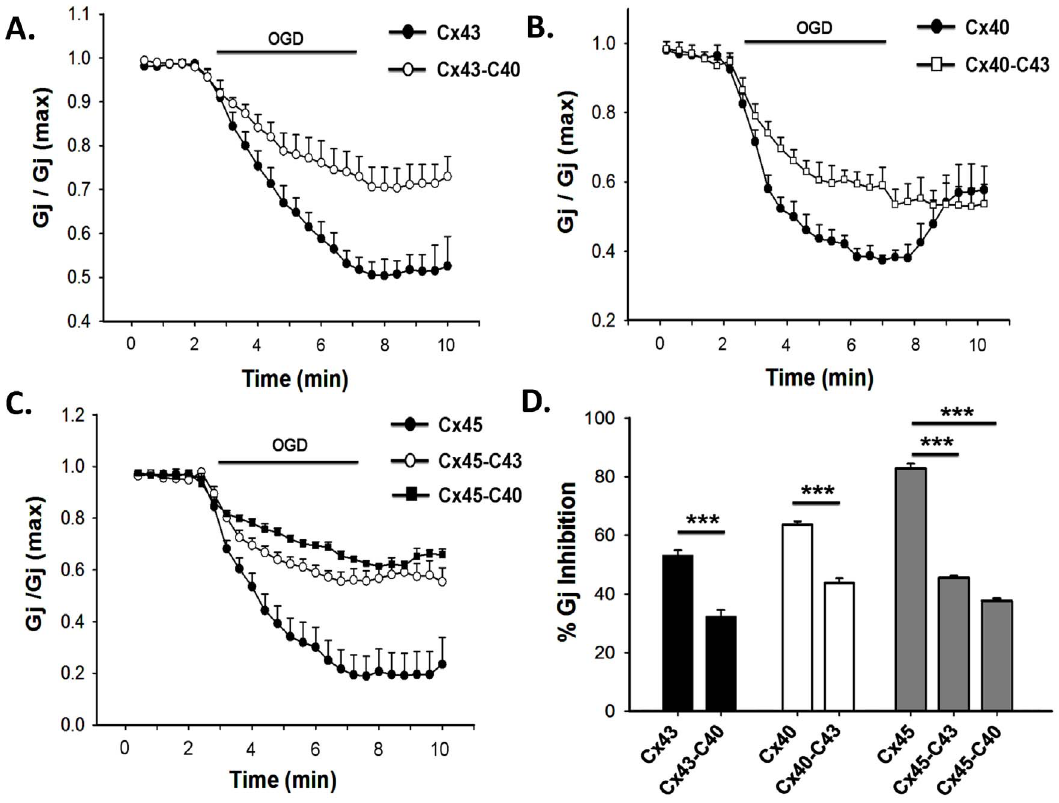
Figure 10. Effect of OGD on gap junctions made of different chimeric connexions. A , chimeric Cx43 with the CT of Cx40 (Cx43-C40) and B , Cx40 with the CT of Cx43 (Cx40-C43) uncoupled to a lesser extent compared to the corresponding wild type. C . Comparison of the uncoupling of wild type Cx45 and Cx45 chimeras containing CT of Cx40 and Cx43. D , statistical representation of the extent of uncoupling of different chimeras. Values are the mean 6 SEM of 5-7 independent experiments. ***, p ,